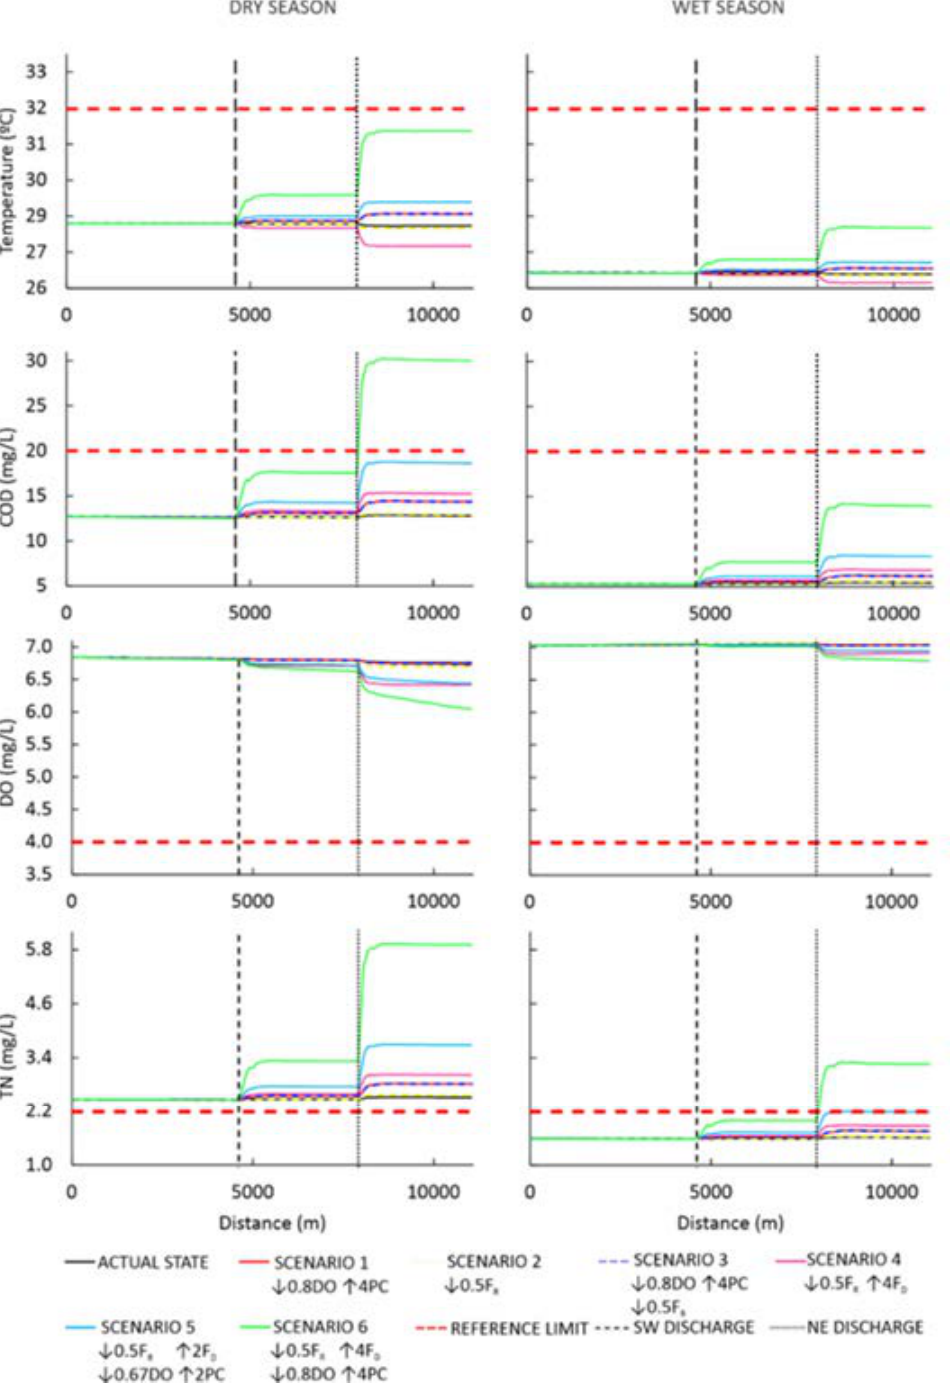
Fig. 9: Longitudinal profiles for temperature, COD, DO y TN